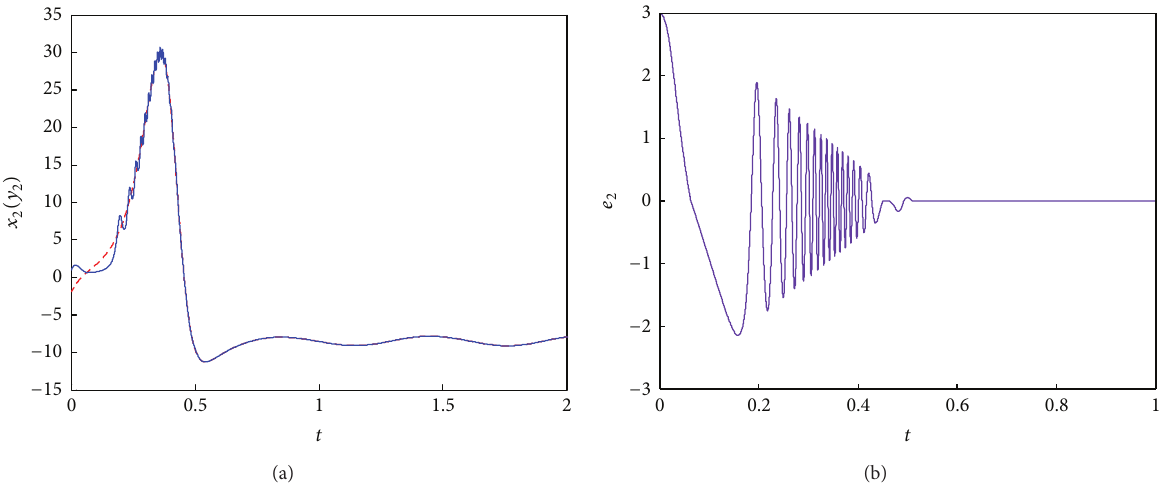
Figure 2: Time series and synchronization error of trajectories of the Lorenz system and the L¨u system: (a) 𝑥 2 (𝑦 2 ) versus 𝑡 ; (b) 𝑒 2 versus 𝑡 .